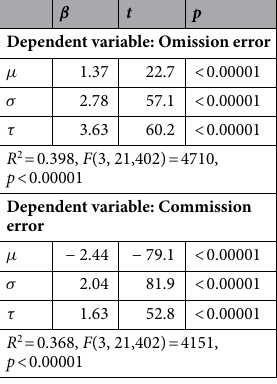
Table 2. Multiple regression predicting each error with exGaussian